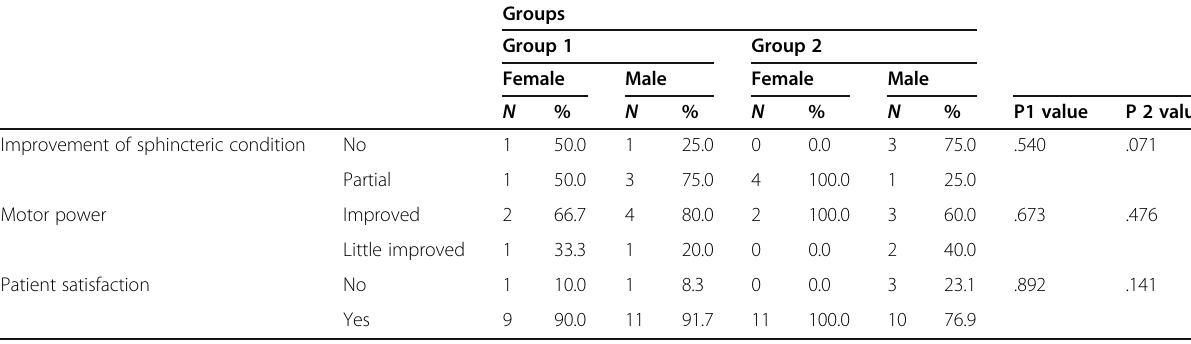
Table 4 Association of sex and surgical outcome in the studied groups